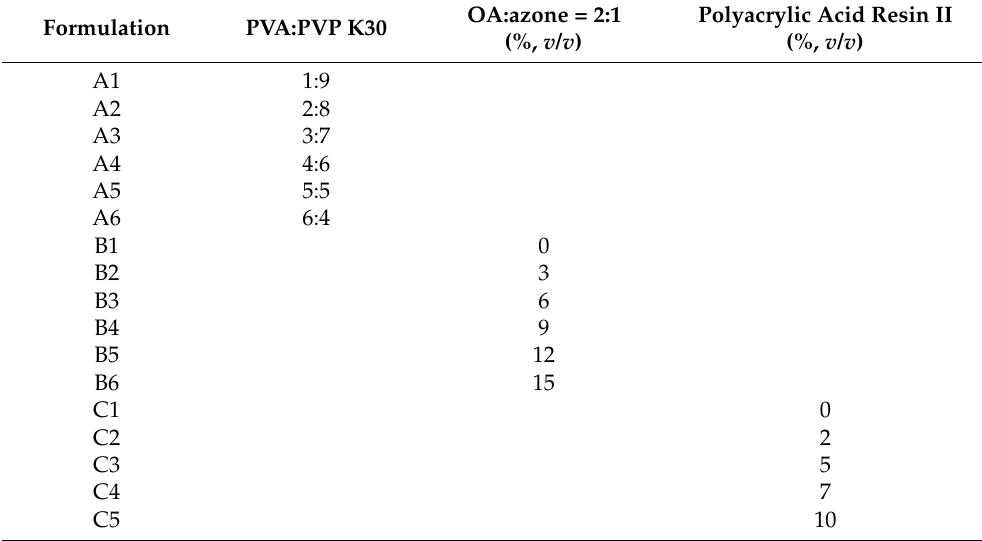
Table 2. Formulation of LP-VPH compound transdermal drug delivery